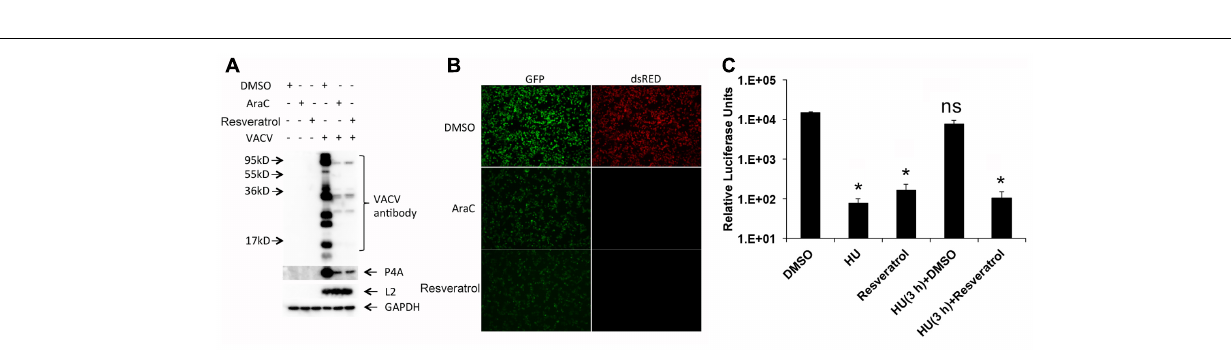
FIGURE 5 | Resveratrol suppresses VACV late, but not early gene expression. (A) HeLa cells were infected with VACV at an MOI of 1 in the presence of DMSO, AraC (40 µ g/mL), or resveratrol (50 µ M). At 24 hpi, the expression of viral proteins in infected cells was detected by western blotting using the indicated antibodies. (B) HeLa cells were infected with a recombinant VACV carrying a GFP gene under an early/late VACV promoter and a dsRED gene under a late VACV promoter at an MOI of 1 in the presence of DMSO, AraC (40 µ g/mL), or resveratrol (50 µ M). The expression of GFP and dsRED was observed and imaged using a fluorescent microscope. (C) HeLa cells were infected with VACV-P11-Fluc at an MOI of 1 and treated with hydroxyurea (HU, 10 mM) from 0 to 3 hpi. Then hydroxyurea-containing medium was washed away and replaced with cell culture medium containing DMSO or resveratrol (50 µ M), and further incubated for another 3 h until luciferase activity in the infected cell lysates was measured. Luciferase activities from infected cells treated with only DMSO, hydroxyurea, or resveratrol through 0–6 hpi were also measured. The asterisk indicates significant difference ( P < 0.05) between control and treated cells. The ns indicates no significant difference. The error bar indicates standard deviation.